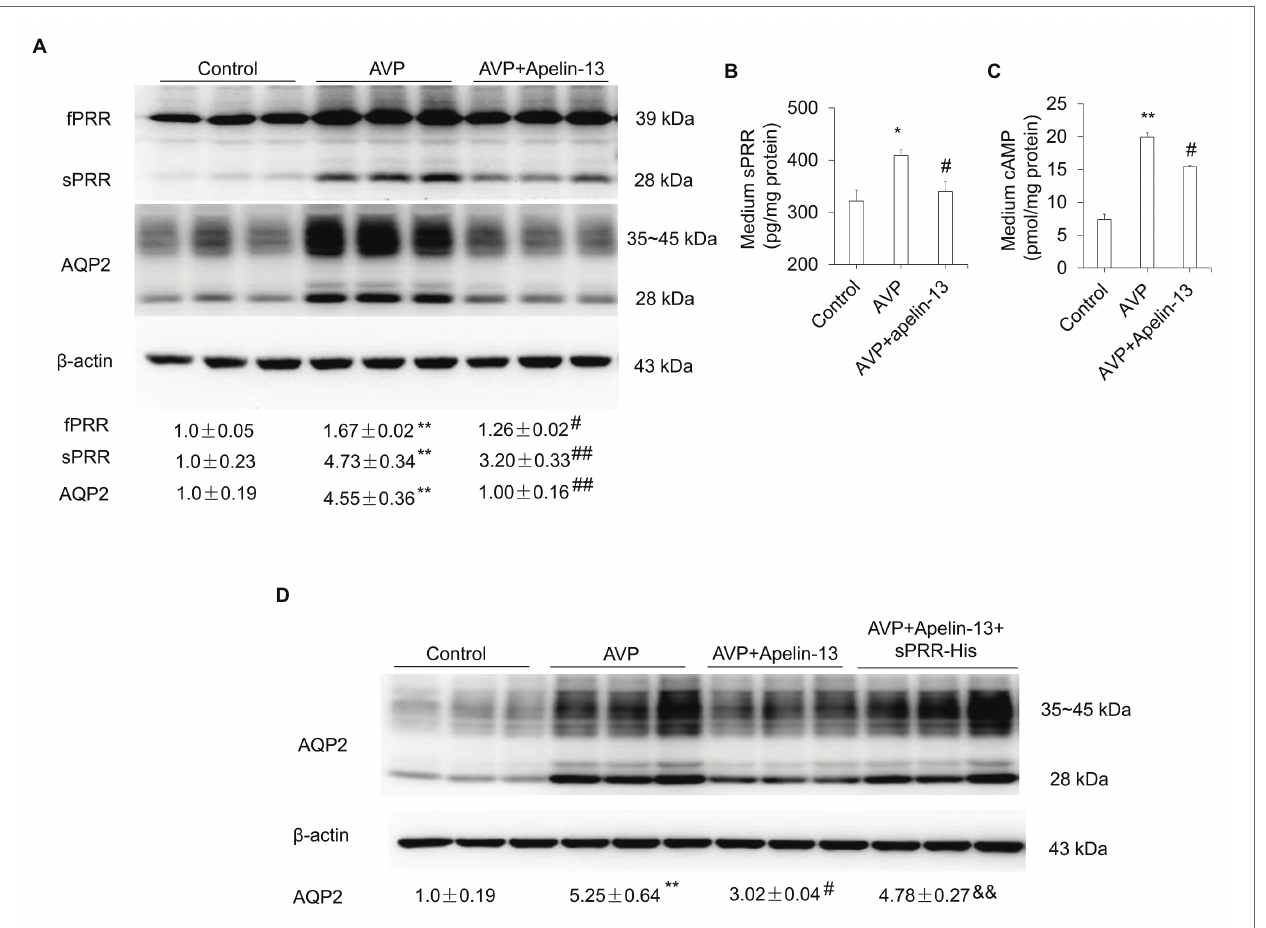
FIGURE 6 | Apelin-13 reduces AQP2 expression through inhibition of sPRR generation in primary IMCD cells. (A) Effect of apelin-13 on PRR expression in antidiuretic action of vasopressin (AVP)-treated IMCD cells. Cells were pretreated with 100 nM apelin-13 and then treated with 10 nM AVP for 24 h. The expression of PRR and AQP2 protein was analyzed by immunoblotting and normalized by β -actin. (B) Medium sPRR levels. (C) Medium cAMP levels. n = 3 per group, repeat three times. Data are mean ± SEM. * p < 0.05 and ** p < 0.01 vs. Control; # p < 0.05 and ## p < 0.01 vs. AVP. (D) Role of sPRR on AQP2 protein expression in AVP + apelin-13-treated IMCD cells. Cells were pretreated with 100 nM apelin-13, or in combination with 10 nM sPRR-His, then treated with 10 nM AVP for 24 h. The expression of AQP2 protein was analyzed by immunoblotting and normalized by β -actin. n = 3 per group, repeat three times. Data are mean ± SEM. ** p < 0.01 vs. Control; # p < 0.05 vs. AVP, && p < 0.01 vs. AVP +